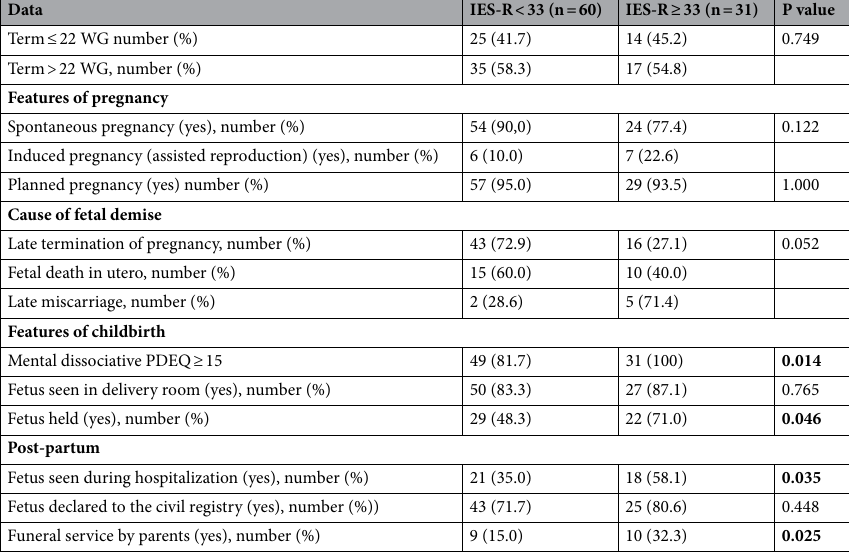
Table 4. Associated factors/IES-R score ≥ 33 M1. % percentage, PDEQ Peritraumatic Dissociative Experiences Questionnaire, WG weeks of